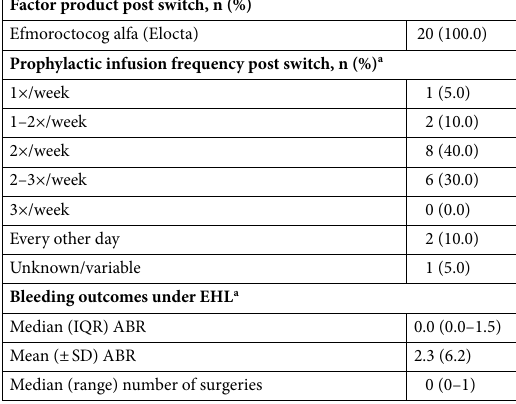
Table 3. Post switch (EHL) data (n = 20). Factor products, prophylactic infusion frequency and bleeding outcomes for persons with SHA after switching to EHL (Elocta, rFVIII-Fc). a Here, n = 19, as values were not recorded, and therefore not available for one